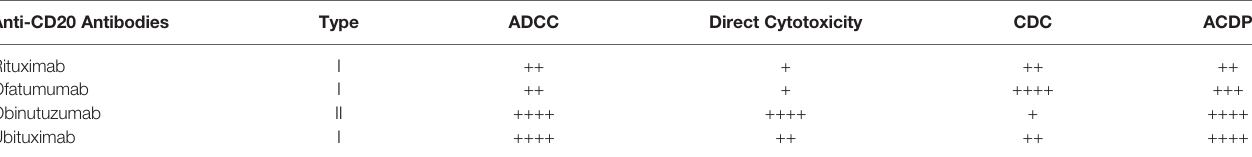
TABLE 1 | Chimeric and humanized anti-CD20 determines different effects on their cell targets depending on their structure, number and extension of the binding sites. Anti-CD20 Antibodies Type